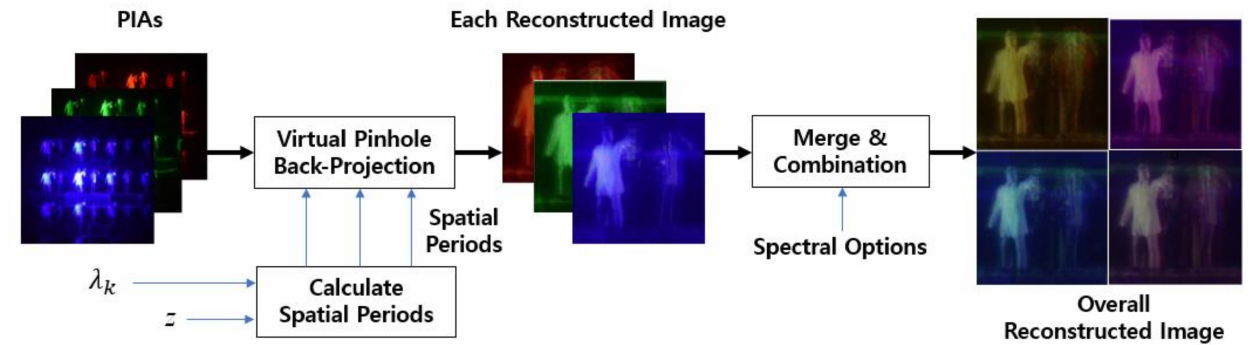
Figure 7. Proposed multi-wavelength computational